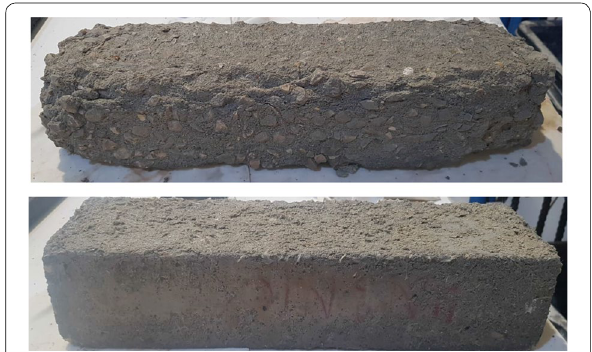
Fig. 11 View of specimens R20 (top) and R10–H20–T1 (bottom) after 108